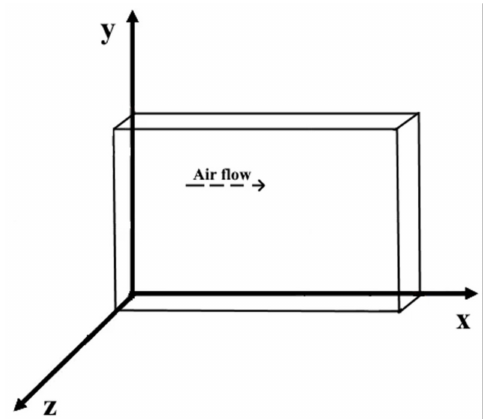
Figure 8. Control volume of the airflow movement between the